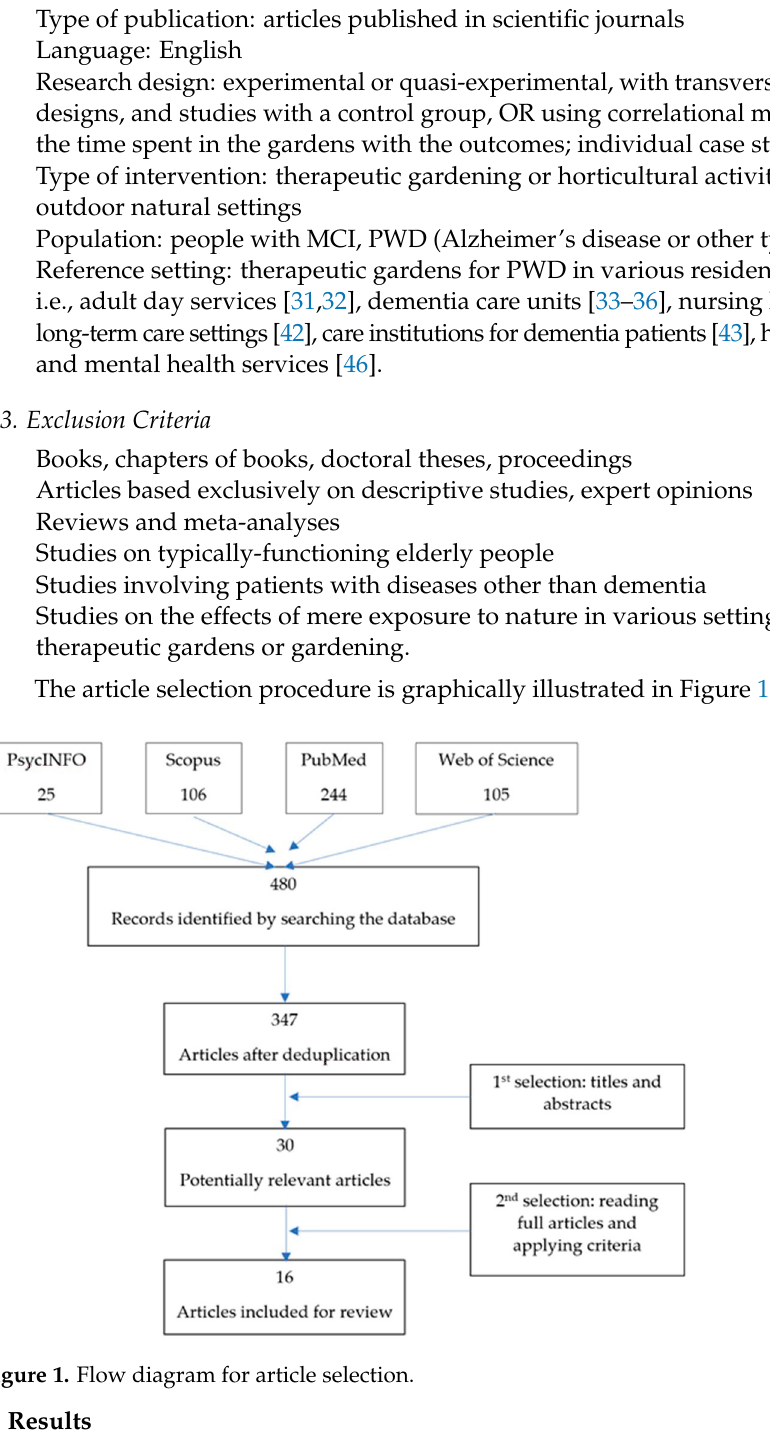
Table 1. Main characteristics of the studies.